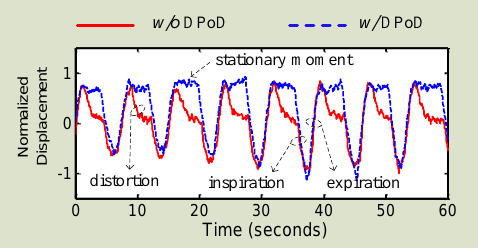
Figure 11. Respiration motion measured by AC coupled Doppler radar with and without using the proposed DPoD technique.